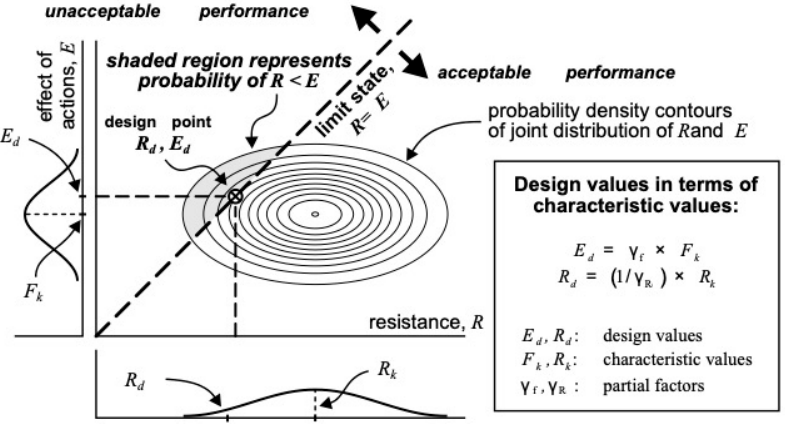
Figure 1. Schematic representation of limit state design (after [14]).